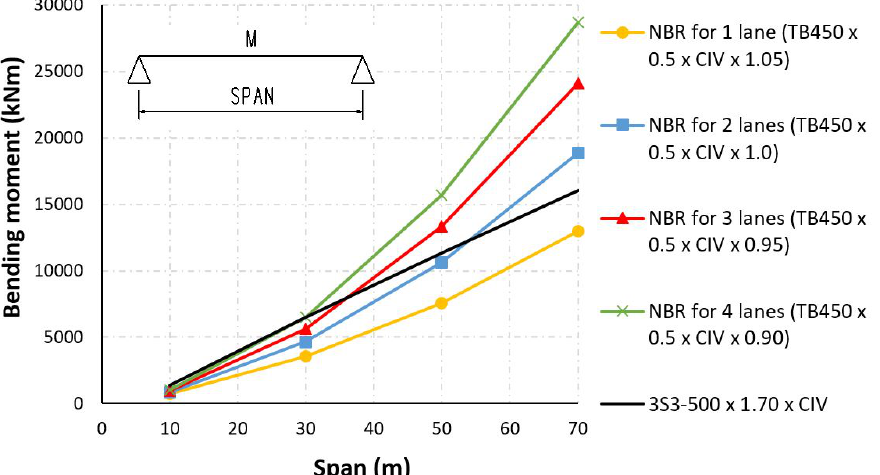
Figure 24. Comparison between models for maximum bending moment at span in simply supported